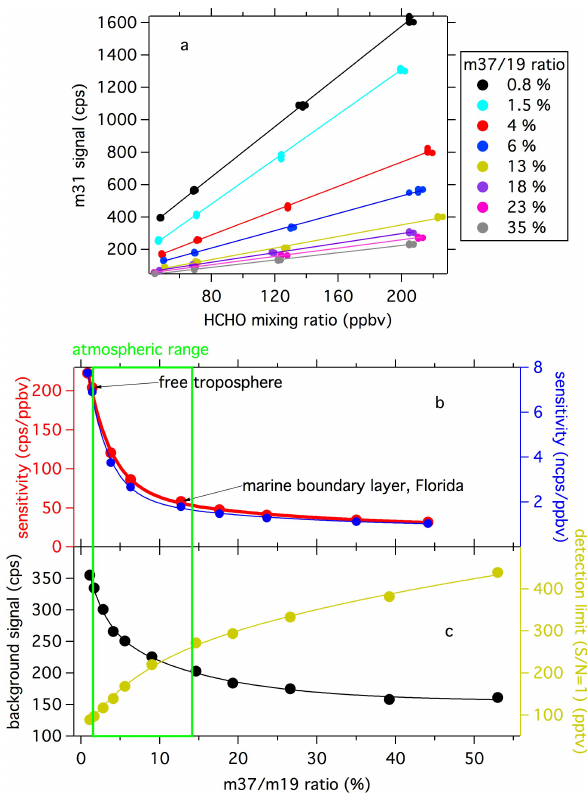
Fig. 3. (a) Calibration curves of the PTR-MS mass31 versus HCHO mixing ratio (ppbv) at different humidities. (b) Sensitivity for HCHO dependent on the humidity. (c) The background signal and the detection limit for HCHO dependent on the